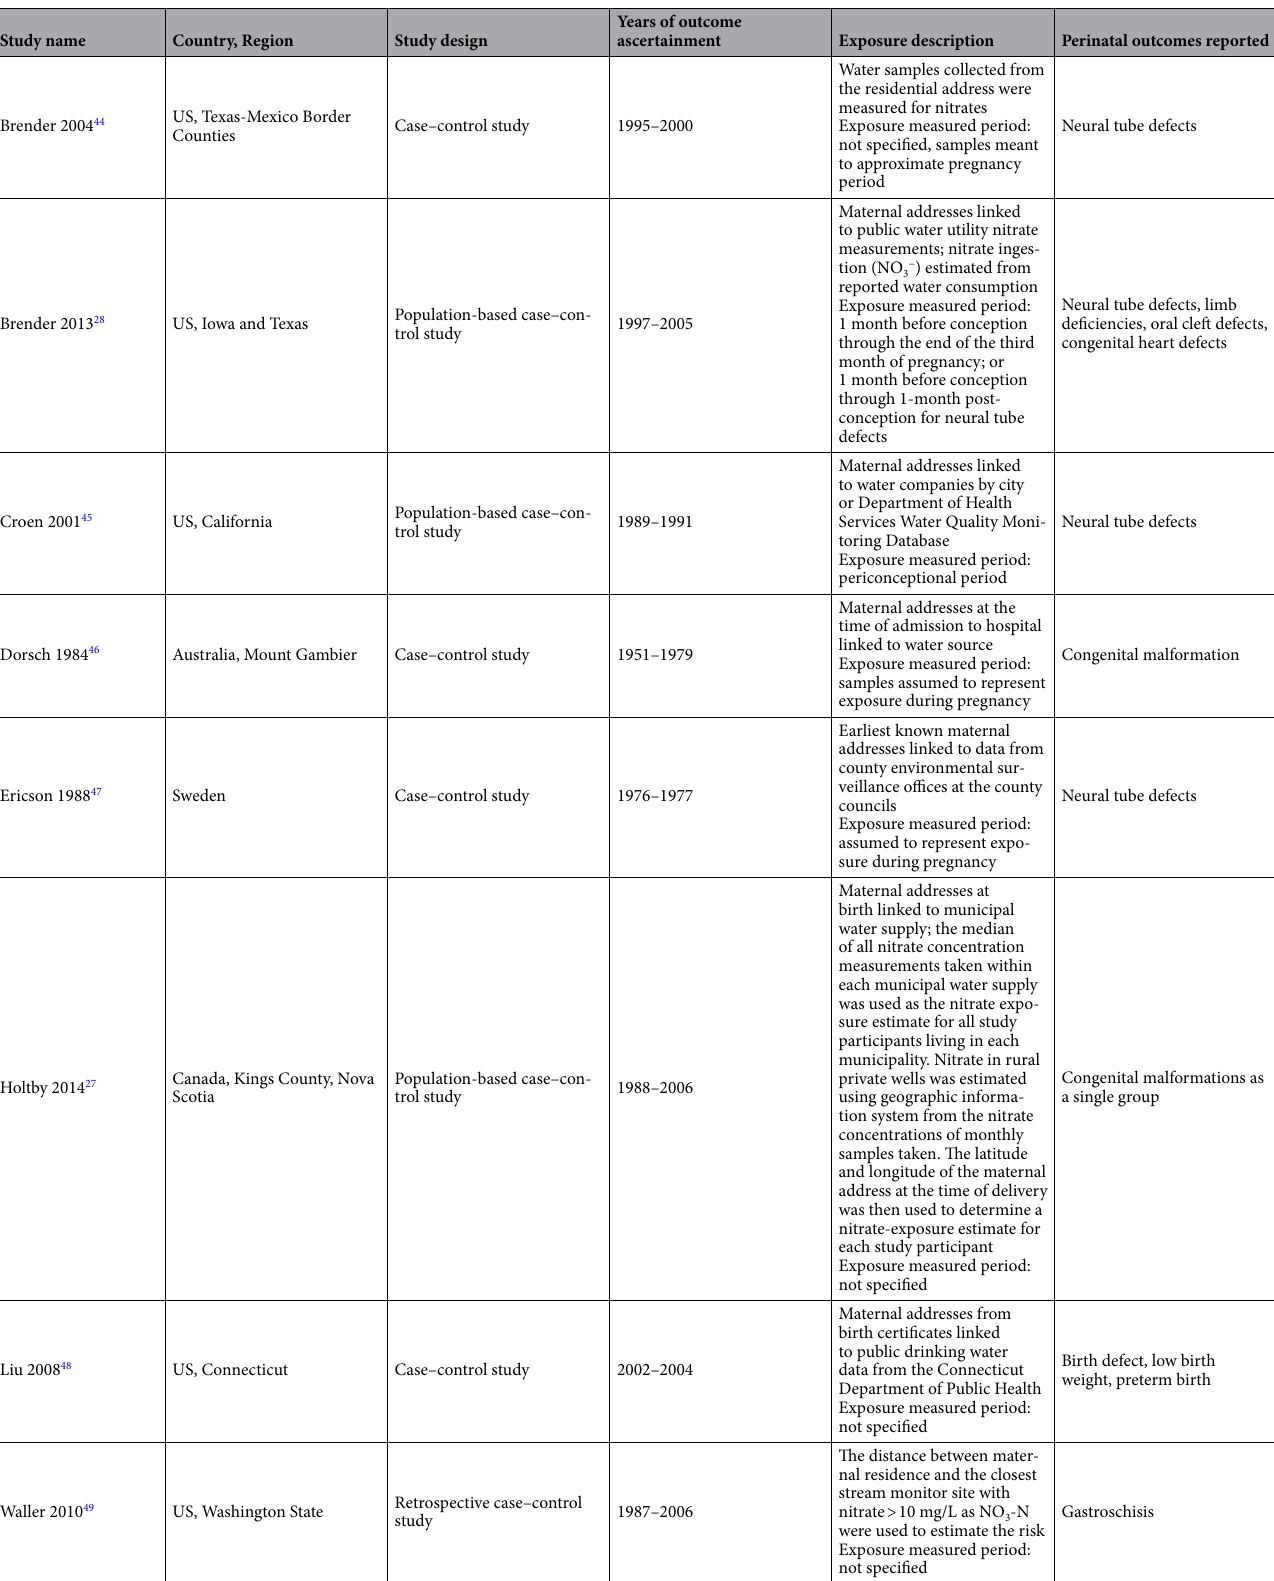
Table 1. Study characteristics. The cohorts reported by Migeot 2013, Limousi 2014 and Albouy-Llaty 2016 are births in the same place in different periods, but there are overlaps between these three cohorts. The cohorts reported by Coffman 2021, Coffman 2022, Stayner 2022 and Thomsen 2021 are births in the same place in difference periods, but there are overlaps between these four cohorts. SGA =